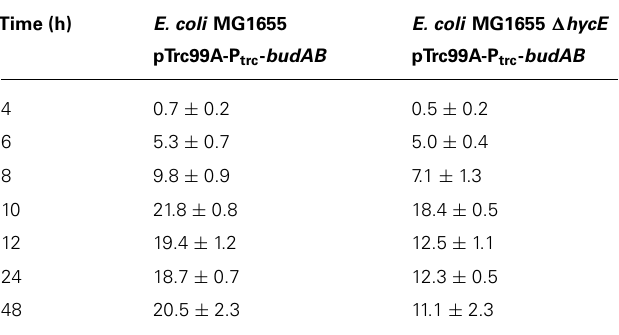
Table 4 |Acetoin production (in mM) by E. coli MG1655 containing pTrc99A-P trc - budAB or E. coli MG1655 (cid:2) hycE